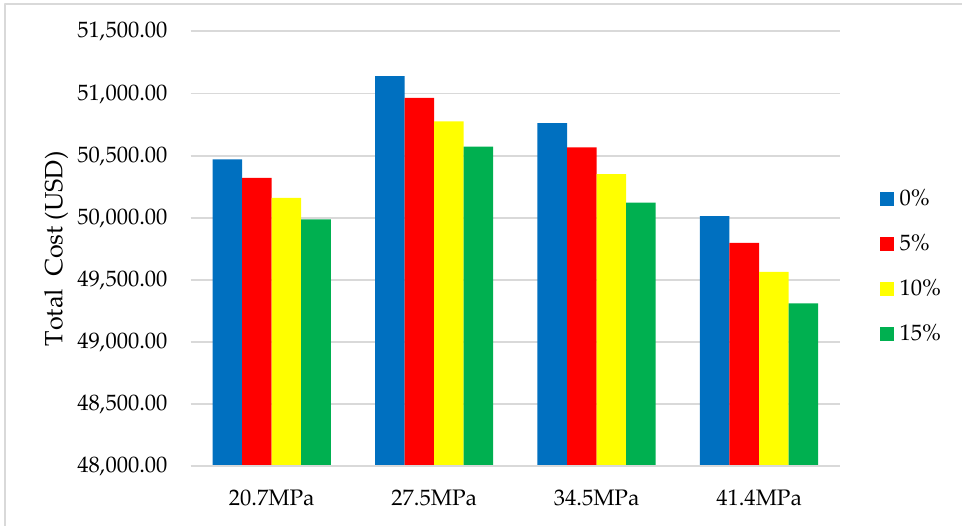
Figure 5. Three-story total cost with different concrete design strengths with CS as SCM.